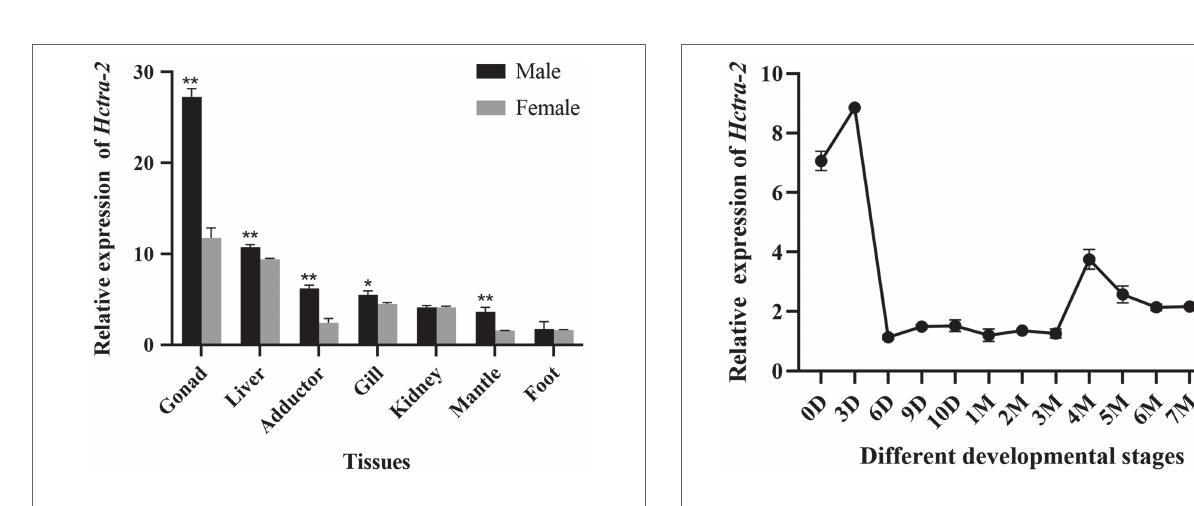
FIGURE 5 | Relative expression of Hctra-2 gene in different developmental periods. (D: days; 0–10 days is embryonic period; M: months; 1–8 mouths is